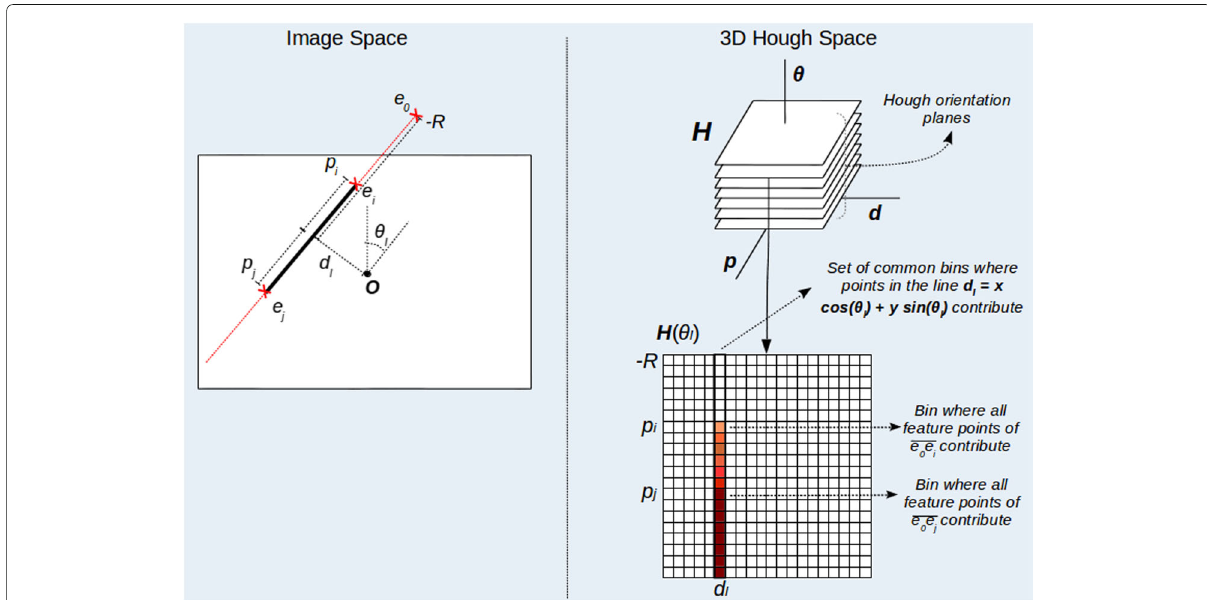
Fig. 2 3D Hough space and line segment representation. Points of a line l ( d l , θ l ) contribute to a subset of cells situated at d l in the Hough plane H (θ l ) . Specifically, a point e i situated at a position p i relative to the line l ( d l , θ l ) contributes to the subset of cells for which p > = p i . As a conse- quence, the bin H (θ l , d l , p i ) contains the total number of feature points of the segment e 0 e i . Likewise, the bin H (θ l , d l , p j ) contains the number of feature points of e 0 e j . Thus, the difference between the contents of both bins provides the total number of feature points of the segment e i e j